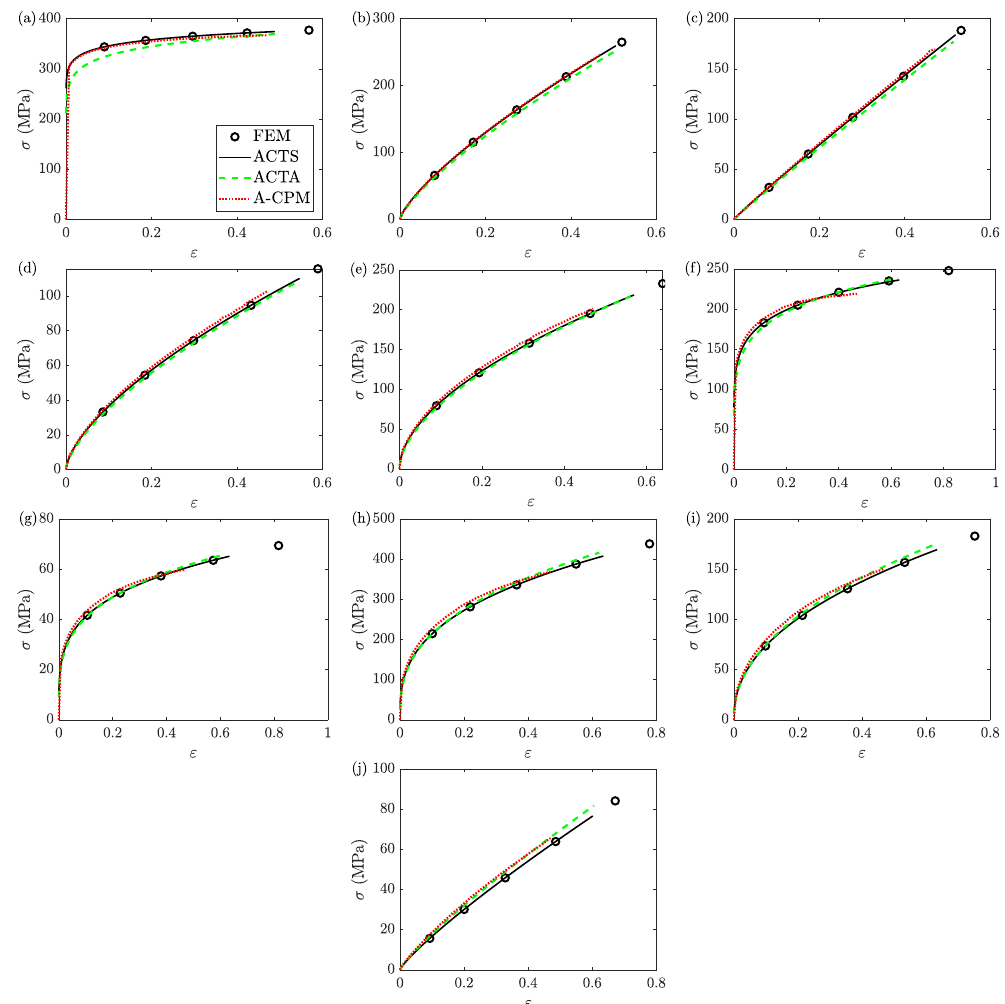
Figure 19. The stress-strain curves at the center of the samples ( a ) 1, ( b ) 2, ( c ) 3, ( d ) 4, ( e ) 5, ( f ) 6, ( g ) 7, ( h ) 8, ( i ) 9, and ( j ) 10. The data are obtained from different models of FEM, ACTS, and ACTA. The results of A-CPM, which are uniform throughout the sample, are added for comparison. Note that the ranges for both stress and strain vary for different samples, and max ( ε A-CPM ) = 0.47 for all